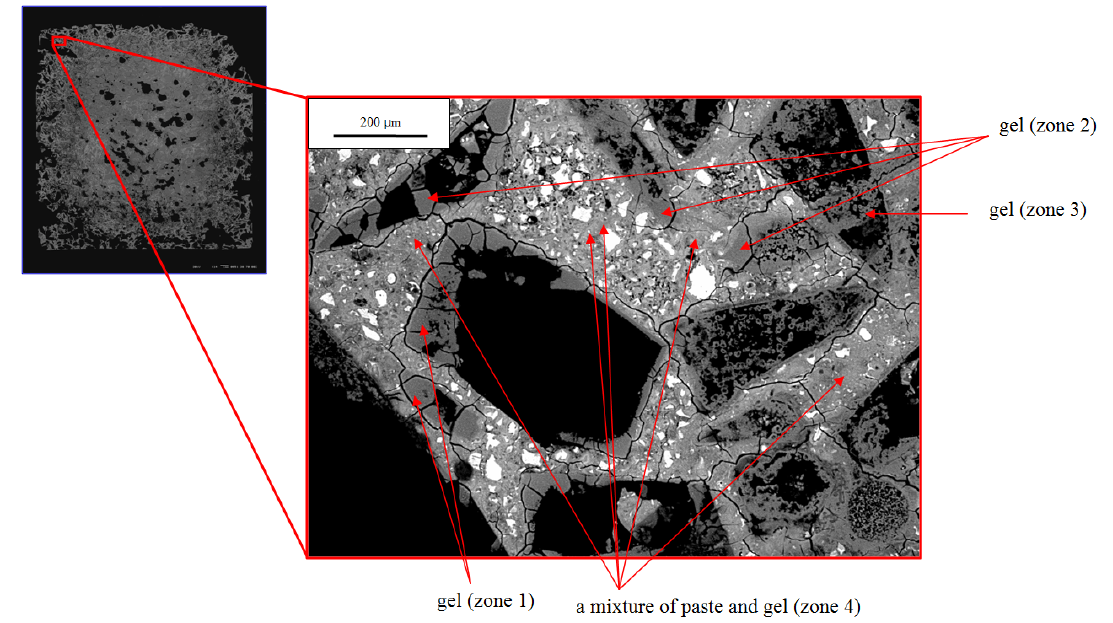
Figure 8. BSE image from 21-day-old mortar at different location.